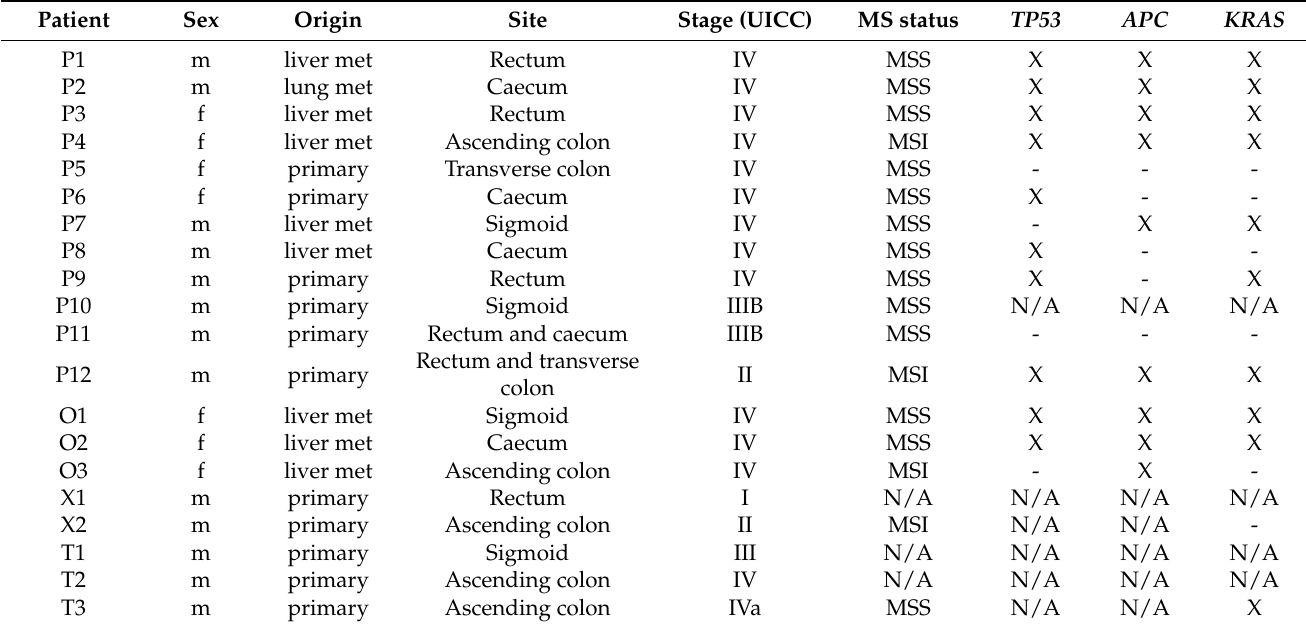
Table 1. Patient overview. Patient-derived colorectal cancer spheroids (P1–P12), organoids (O1–O3), xenografts (X1, X2), and primary colorectal cancer samples (T1–T3) used for single-cell RNA-sequencing. X indicates mutation, - indicates wild type. f, female; m, male; met, metastasis; MS, microsatellite; MSI, microsatellite instable; MSS, microsatellite stable; N/A, not